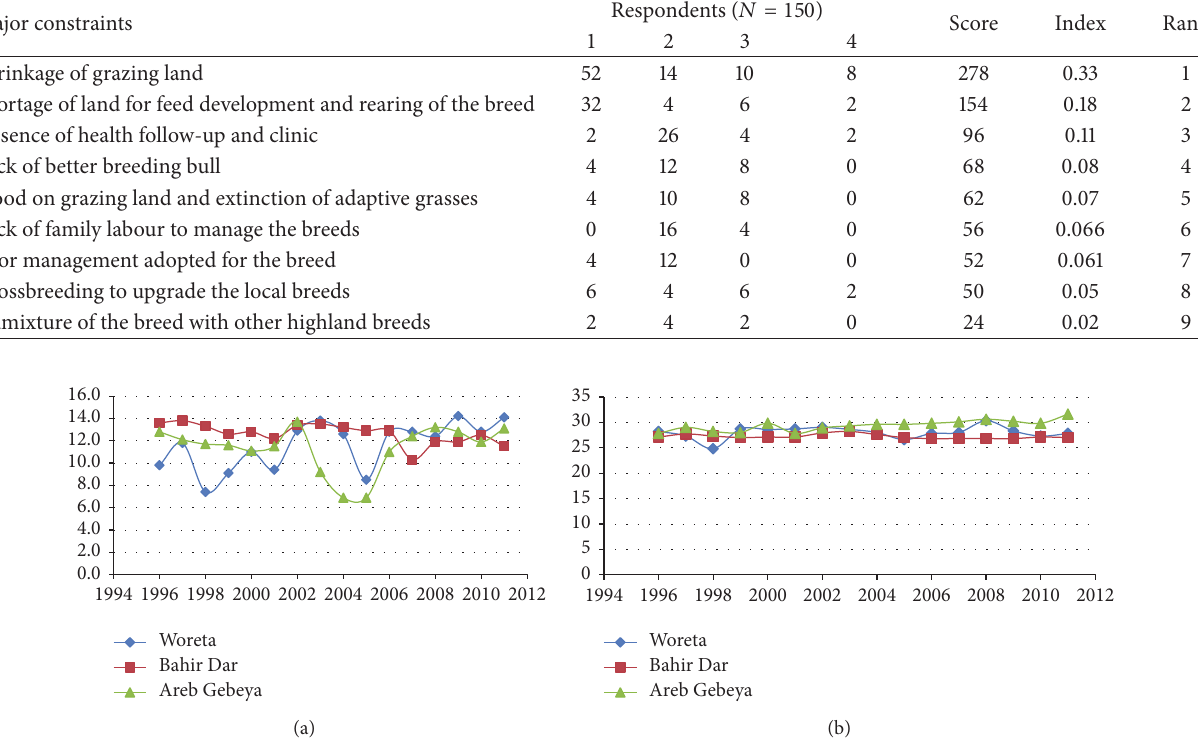
Table 2: Major constraints for the decreasing performance and population status of Fogera cattle. Major constraints